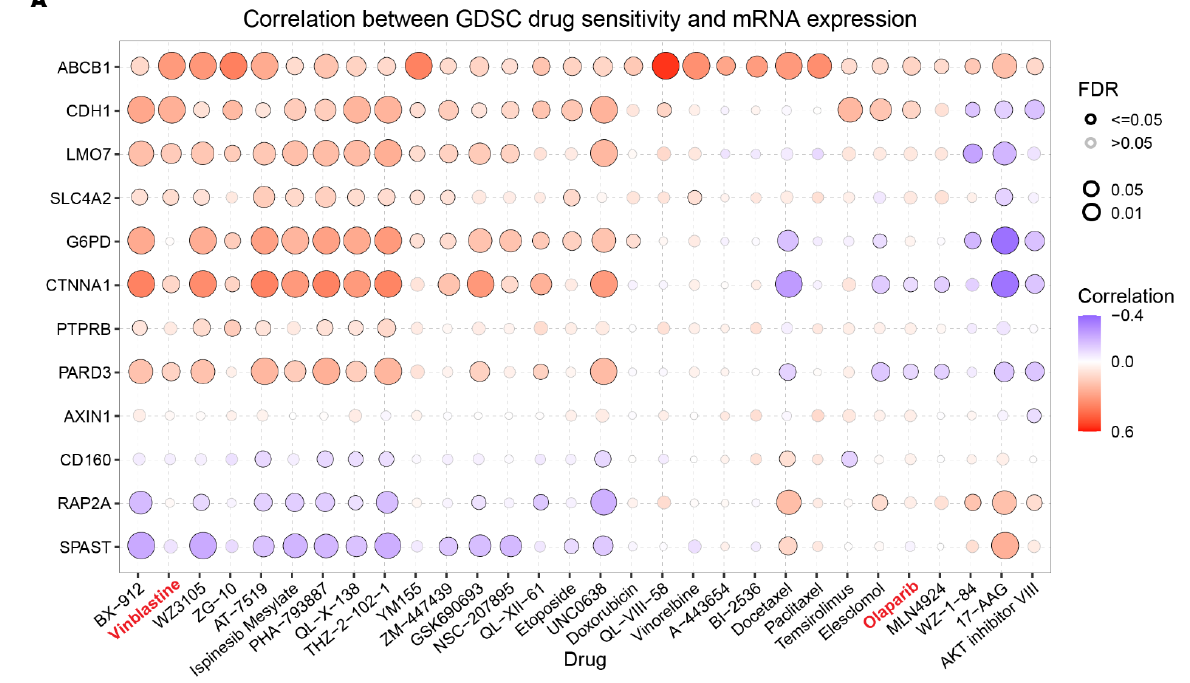
Figure 7. Drugs potency for targeting the 12 PRGs. ( A ) Bubble plot for the top 30 drugs associated with the PRG expression pattern. ( B – D ) The approved drug sorafenib, vinblastine, and Olaparib performance on cell lines derived from liver tumor. 3. Discussion The prognosis of HCC patients is poor, and usually left with very limited treatment options [21]. Hepatocyte polarity is of more and more concern in the research of HCC. In